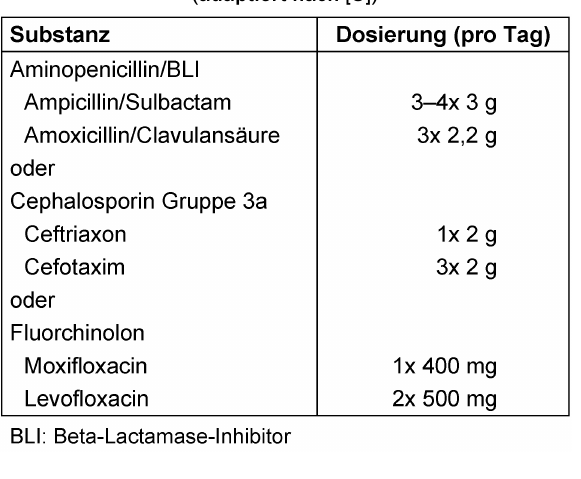
Tabelle 10: Kalkulierte Initialtherapie bei nosokomialer Pneumonie ohne Risikofaktoren für multiresistente Erreger